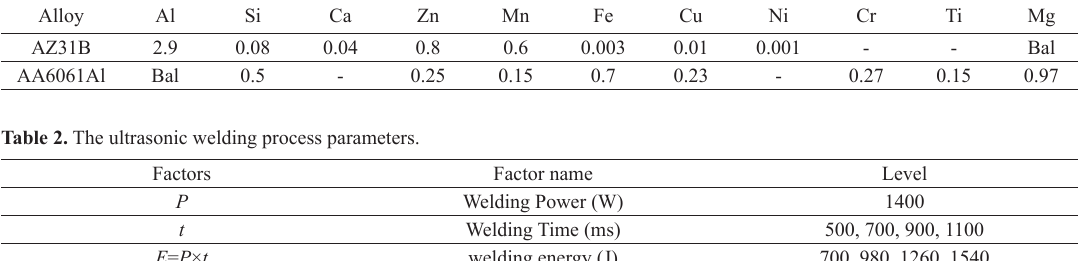
Table 1. Chemical compositions of materials used in experiments (wt.%). Alloy